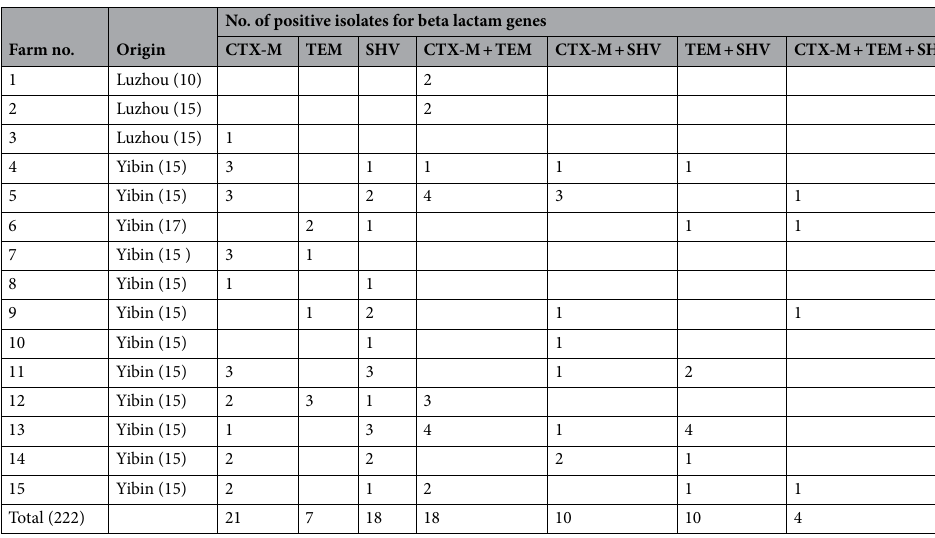
Table 2. The occurrence of the beta lactam genotypes in different farms of the beef cattle of Sichuan- Chongqing Circle, China (n = 222).